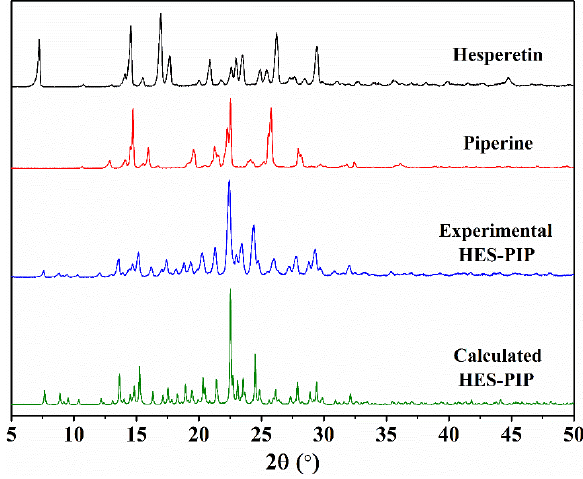
Figure 4. Comparison of experimental and calculated PXRD patterns of HES–PIP cocrystal, HES, PIP.